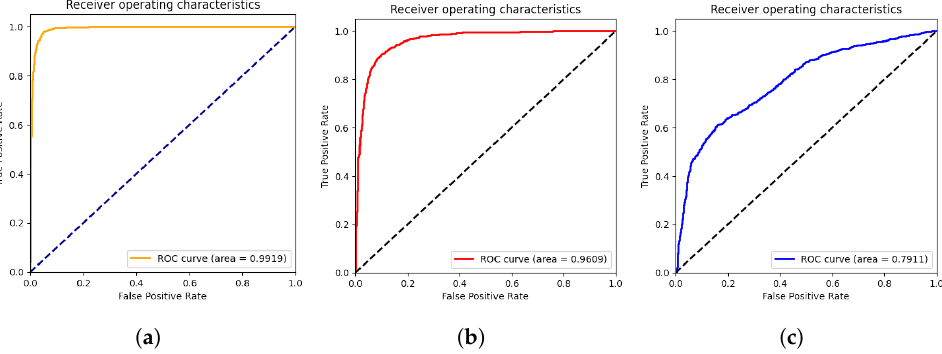
Figure 5. ROC curves of ViT-B16 ( a ), ViT-B32 ( b ), and ViT-L32 ( c ) (COVID-19 vs. Pneumonia vs. Normal)